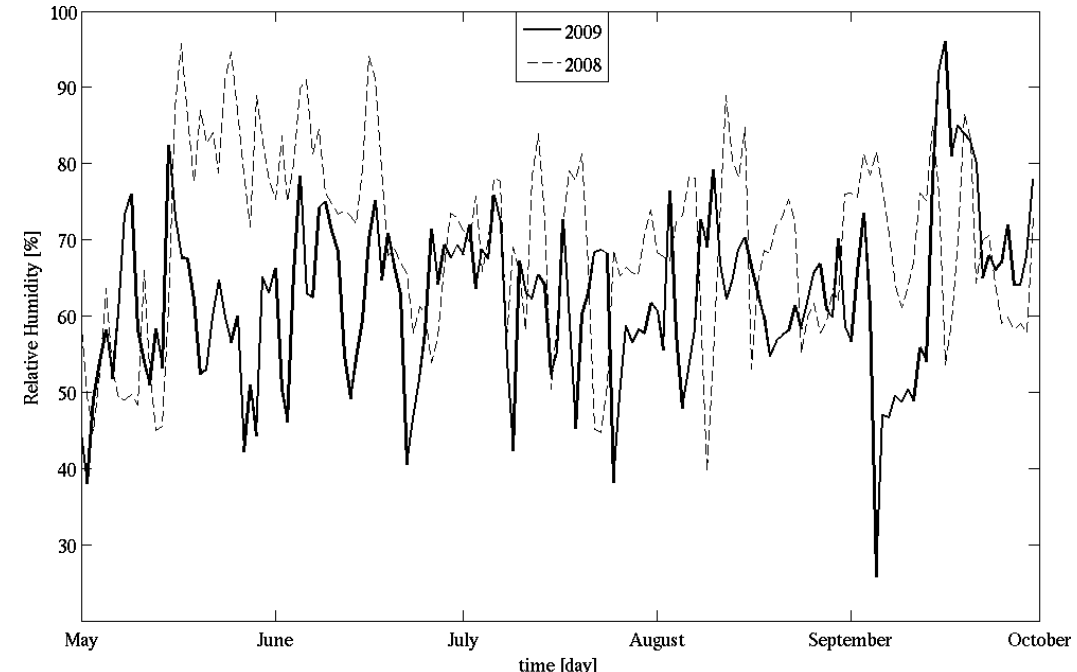
Figure 3. Mean daily air relative humidity (in %) measured in the shelter during 2008 and 2009 vegetative seasons above the Barbera vines at